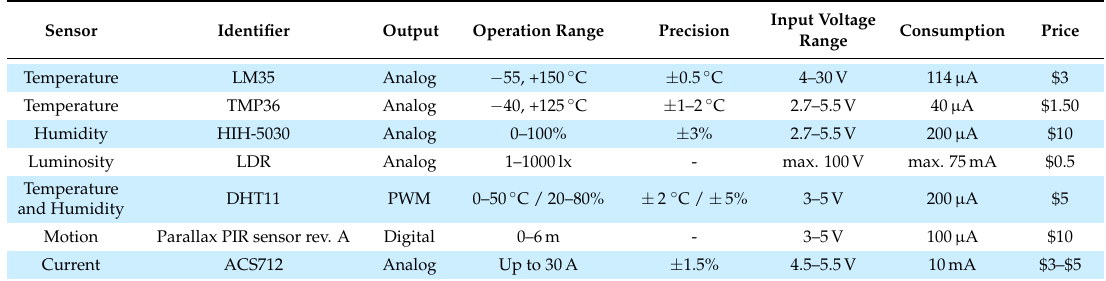
Table 7. Sensors used by ZiWi’s